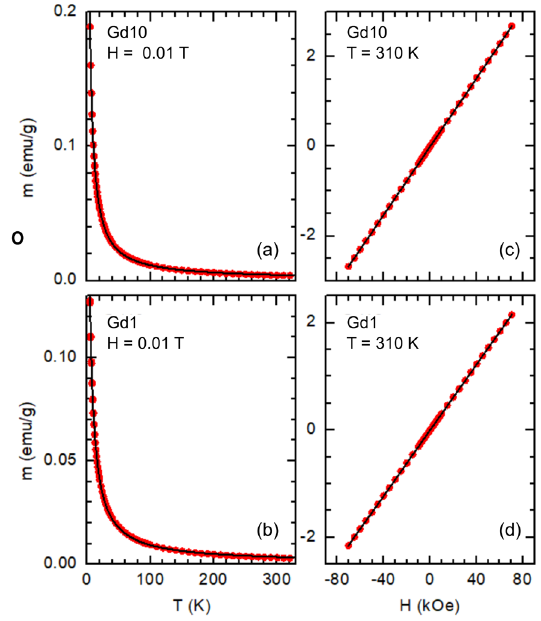
Figure 5. Temperature ( a , b ) and magnetic field ( c , d ) dependences of the magnetic moment of samples Gd10 (126.3 mg) and Gd1 (86.1 mg). The lines are fits of a Curie-Weiss function, Equation (13). Demagnetization effects are negligible (the correction would be ~2–3% at 5 K and strongly decreases on increasing the temperature) and were not taken into